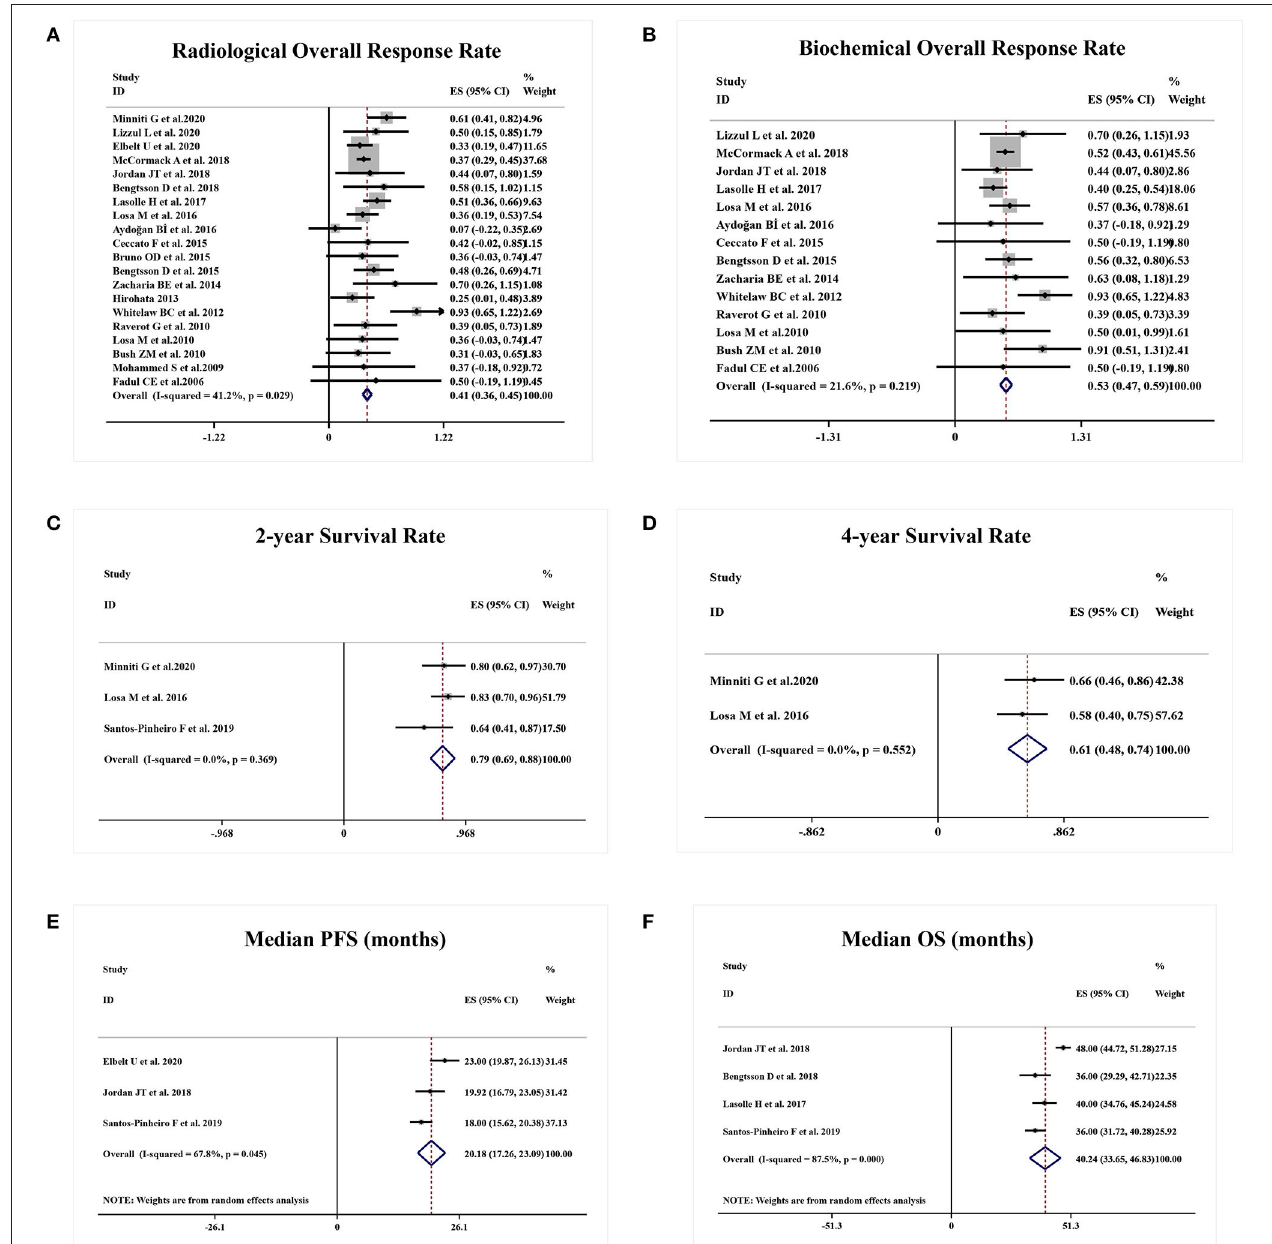
FIGURE 2 | Responsive and survival outcomes of TMZ in APT and PC patients. (A) Radiological overall response rate was achieved in 41% of patients. (B) 53% of patients were biochemically responsive to TMZ. (C,D) 2-year survival rate was 79% and 4-year survival rate was 61%. (E,F) Median PFS and OS were 20.18 months and median OS was 40.24 months,